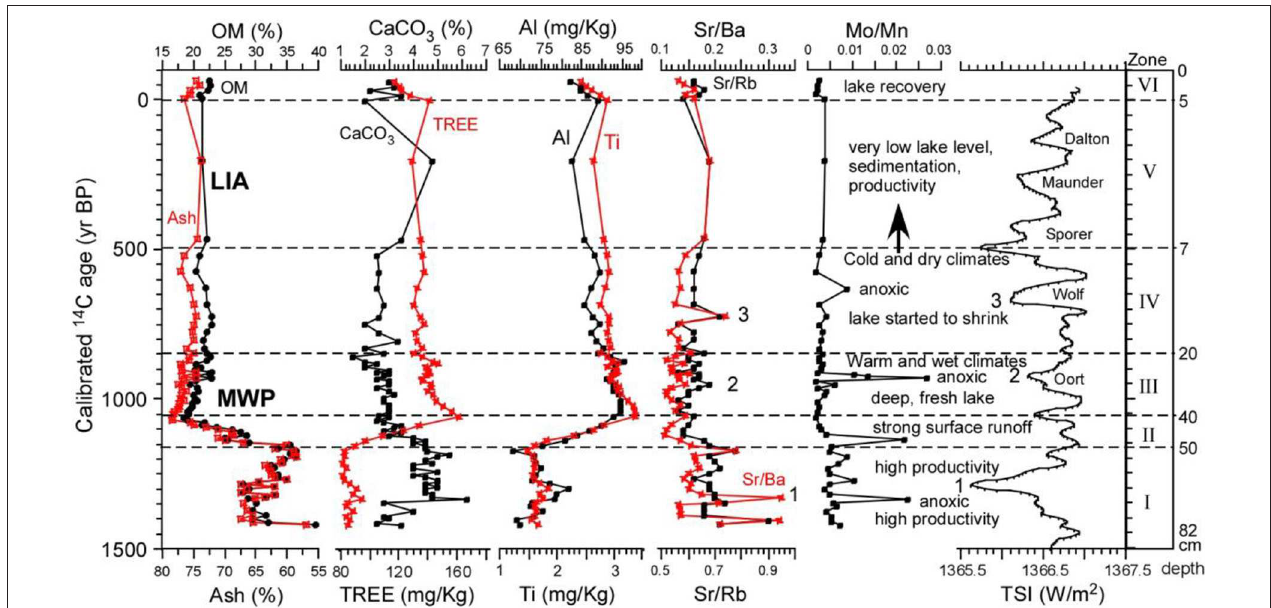
FIGURE 12 | Comparison of important geochemical indices in the Manzherok Lake core with the total solar irradiance (TSI). The TSI curve is a five-point running average of the 5-years resolution TSI data from Steinhilber et al. (2009). Numerical numbers 1, 2, and 3 for the Sr/Ba and the TSI plots denote their correlations.